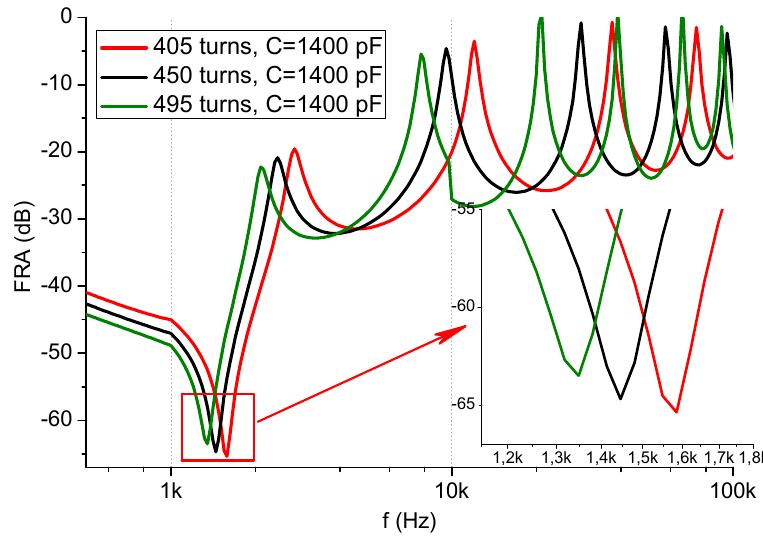
Figure 6. FR modeling for the three positions of the tap changer (405, 450, and 495 turns).